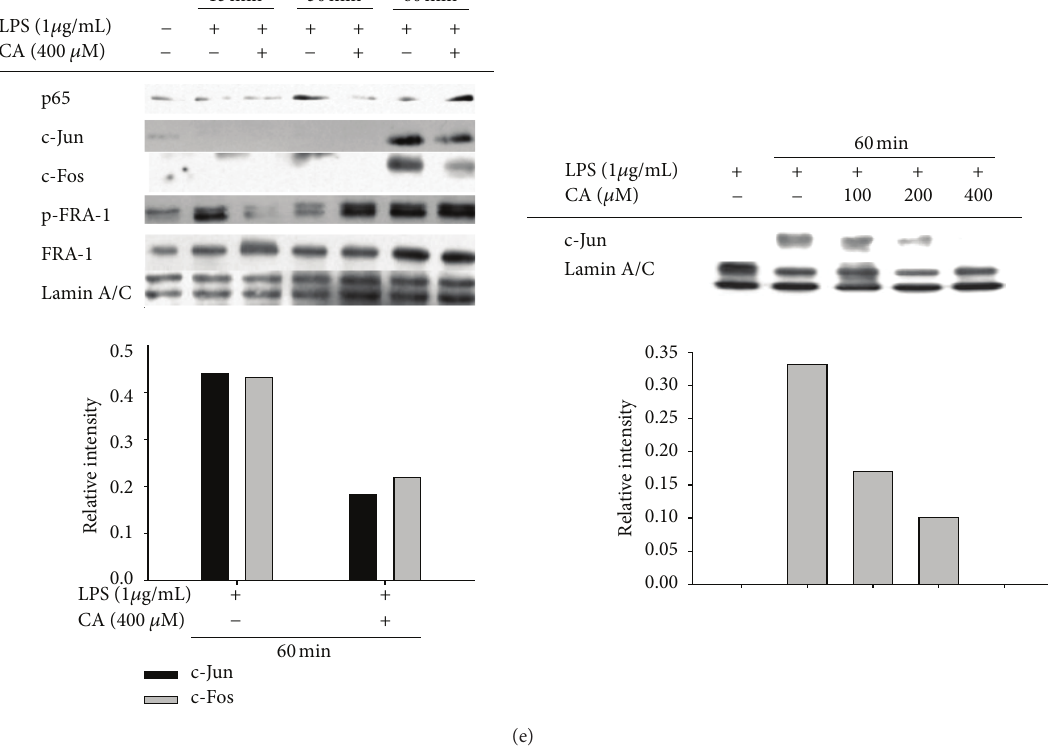
Figure 3: Effect of CA on transcription factor activation. ((a), (b), (c), and (d) left panel) HEK293 cells that had been cotransfected with NF- 𝜅 B-Luc, AP-1-Luc, or CREB-Luc plasmid constructs (1 𝜇 g/mL each) and 𝛽 -gal (transfection control) were treated with CA (0 to 400 𝜇 M) or CA-containing plant extracts (Na-ME, Vc-ME, and Ep-ME (200 to 400 𝜇 g/mL)) in the presence or absence of PMA (100nM) or forskolin (2 𝜇 M). Luciferase activity was measured with a luminometer. (d) HEK293 cell viability was determined by an MTT assay. (e) Levels of p65/NF- 𝜅 B and AP-1 family proteins (c-Jun, c-Fos, FRA-1, and p-FRA-1) in the nuclear fractions of LPS-treated RAW264.7 cells cultured in the presence or absence of CA (100 to 400 𝜇 M) were determined by immunoblotting analyses with antibodies against the total proteins. Relative intensity was calculated using total levels by the DNR Bioimaging system. ∗ 𝑃 < 0.05 and ∗∗ 𝑃 < 0.01 , compared to the